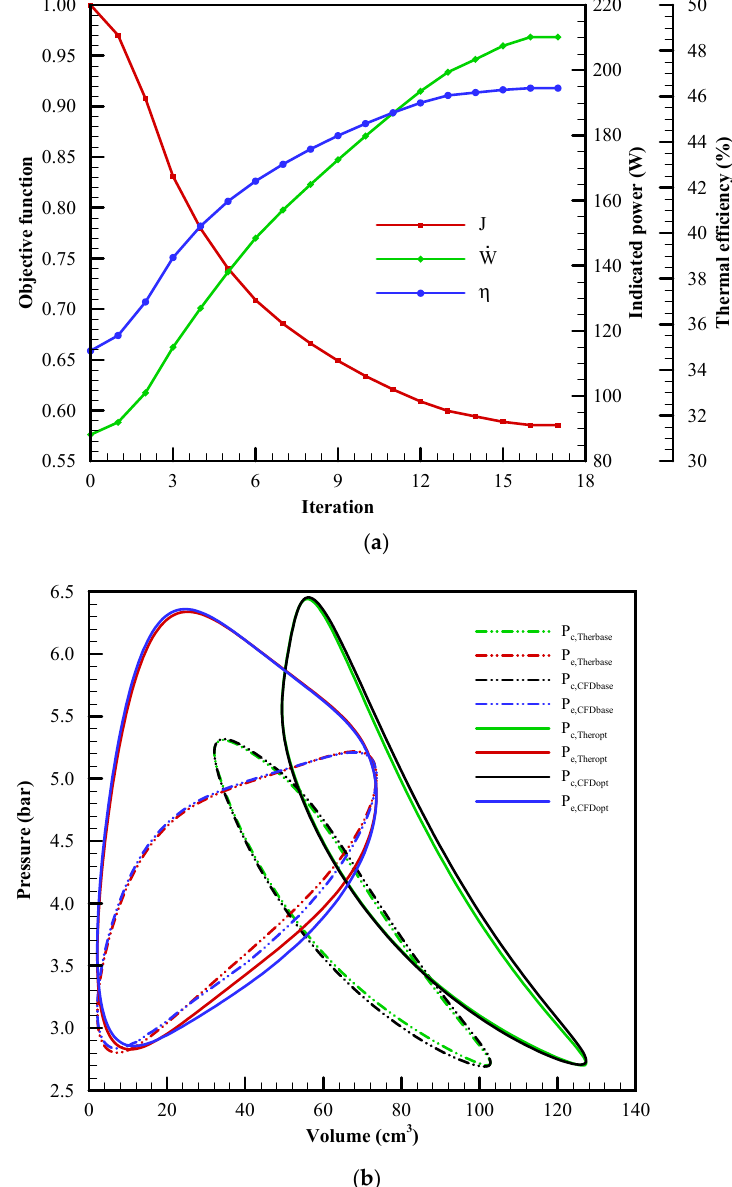
Figure 4. Optimization results for the baseline case: ( a ) variation of the objective function, indicated power, and thermal efficiency with the number of optimized iterations; ( b ) P-V diagrams at the first iteration and the final iteration of the optimization process.